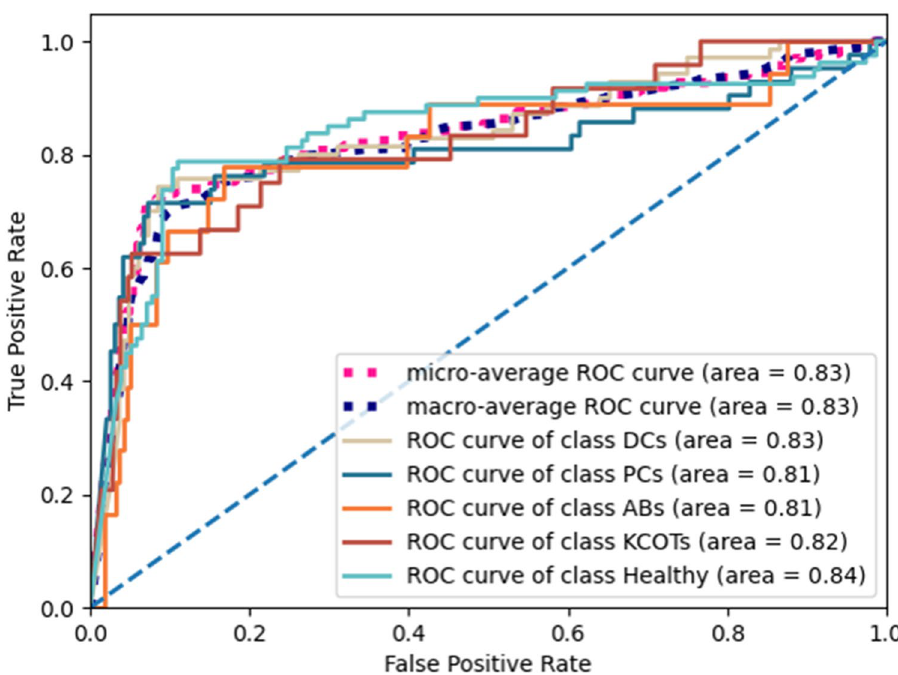
Figure 3. The ROCs and AUC scores of the five-class classification. Healthy samples achieve the highest AUC score than Cysts (DCs and PCs) and tumors (ABs and